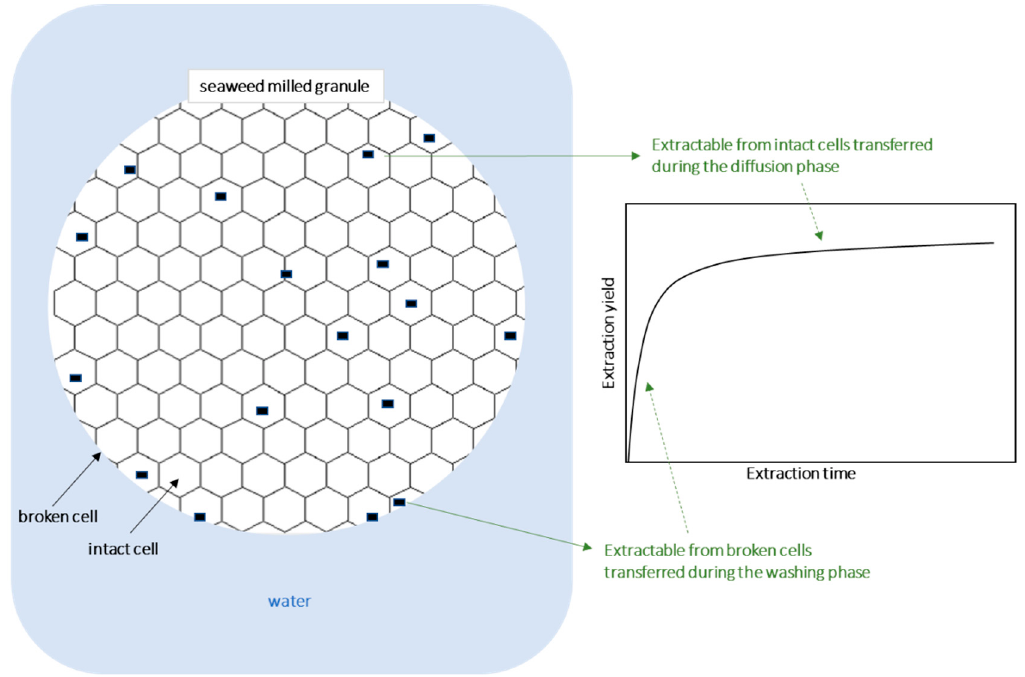
Figure 6. Illustration of the extraction phases.